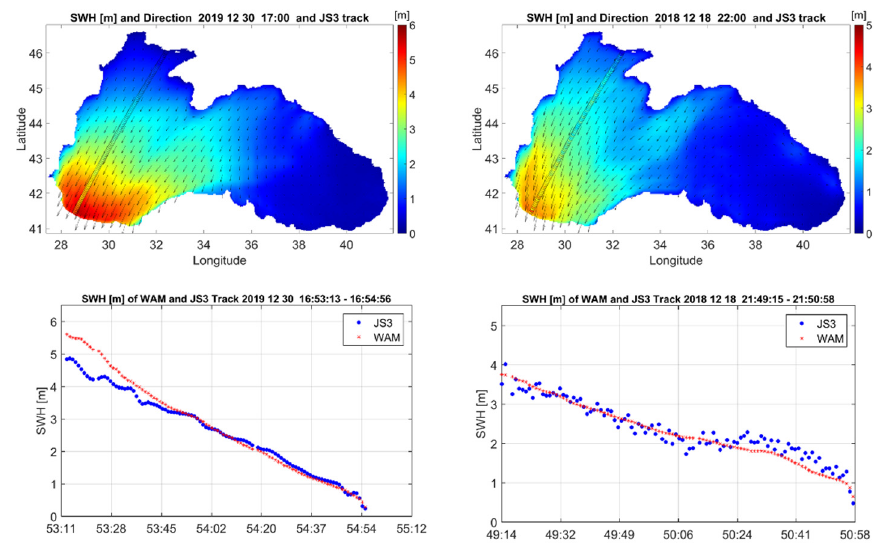
Figure 13. Left : distribution of BS-WAV NRT SWH on 30 December 2019 (17:00 UTC) and a Jason-3 satellite track also on 30 December 2019 (16:53:13–16:54:56 UTC). Right : distribution of SWH on 18 December 2018 (22:00 UTC) and a Jason-3 satellite track on 18 December 2018 (21:49:15–21:50:58 UTC). Table 5. EANs for the current BS-WAV NRT system (all values in centimeters).